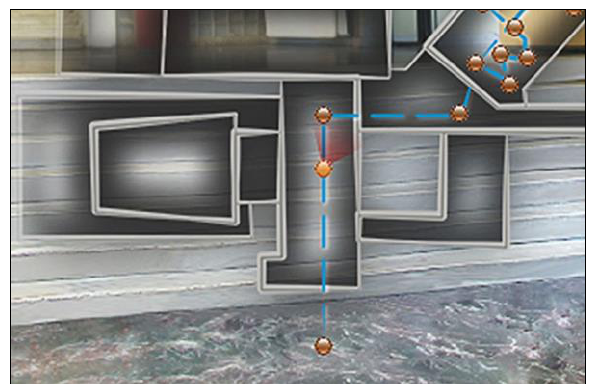
Figure 16. The radar for user’s orientation.